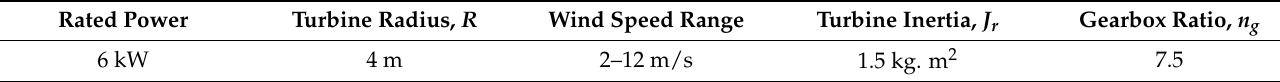
Table A2. Wind turbine